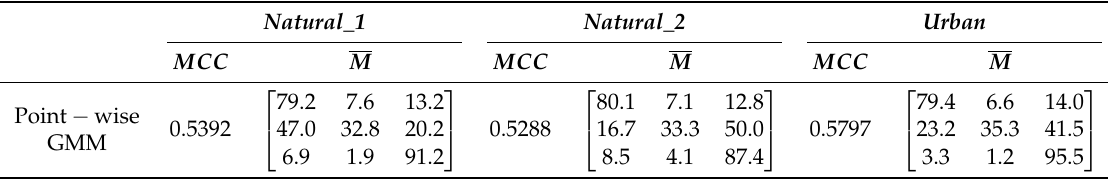
Table 6. Performance of GMM classifier with point-wise neighborhood using feature vector definition F 2 for the evaluation